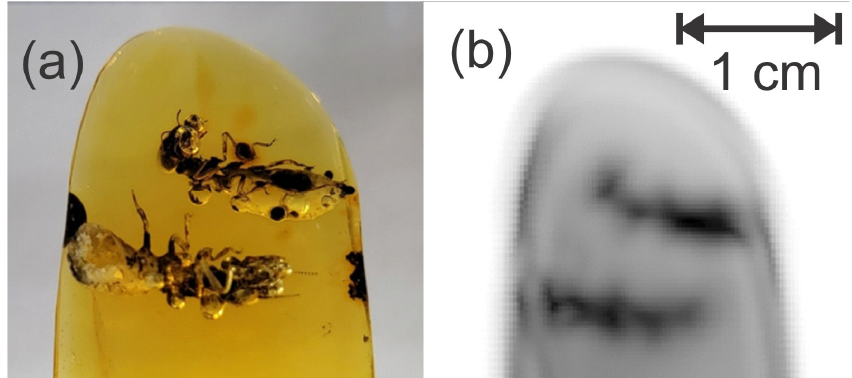
Figure 10. ( a ) Closeup reference picture of the two termite workers in the Dominican amber matrix. ( b ) Terahertz image generated from the natural log of the mean terahertz transmitted amplitude in the 0.5–2 THz band.